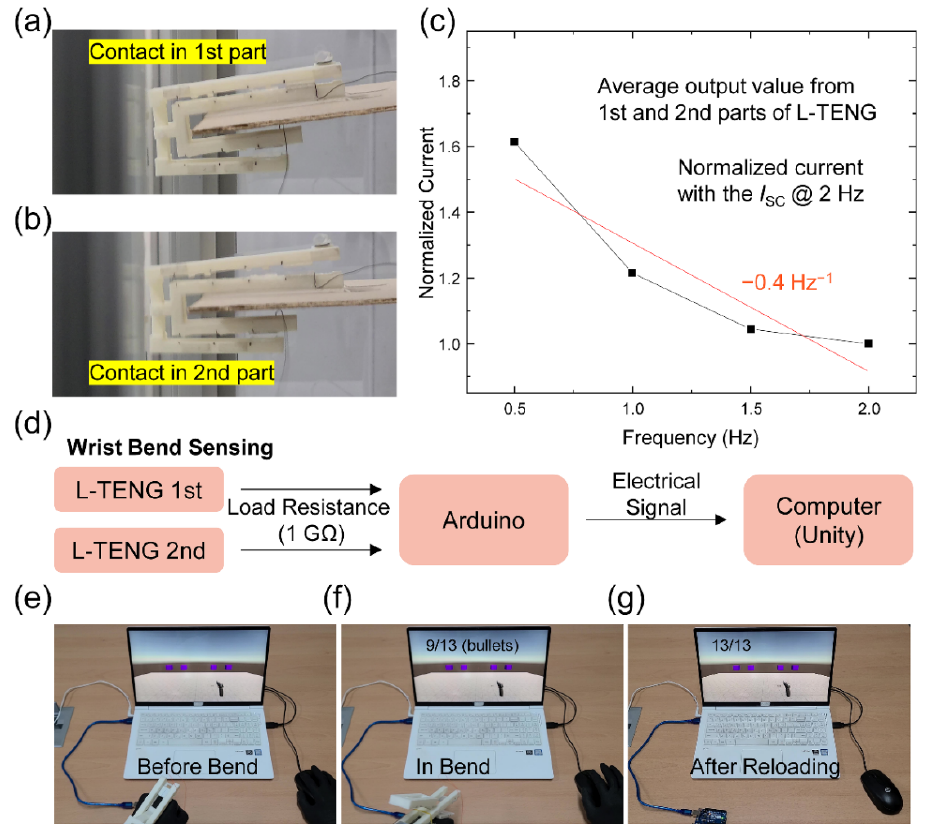
Figure 5. Applications of the proposed L-TENG. ( a , b ) Digital camera image of the setup for sensing vibration. ( c ) Electrical output current result of the vibration sensing. ( d ) Flowchart for sensing wrist bending and triggering reloading motion. Captured image of the gun shooting game: ( e ) after shooting four bullets, ( f ) in bending wrist, and ( g ) after reloading.